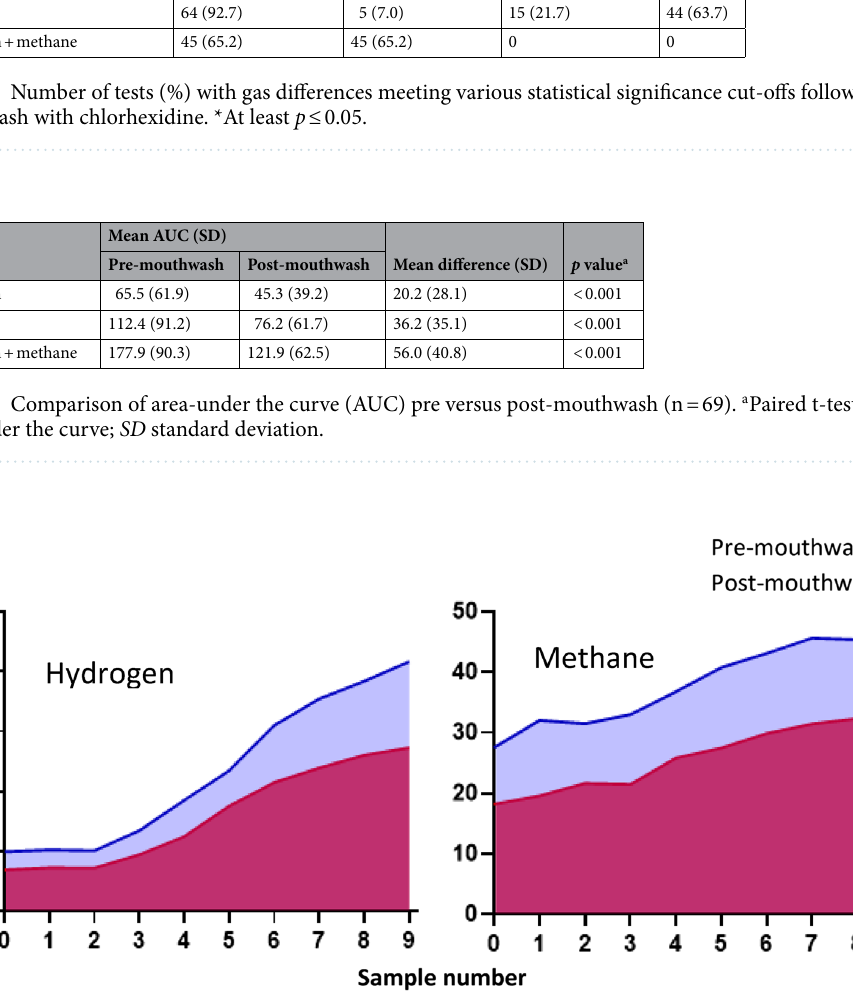
Figure 1. Mean AUC for hydrogen and methane pre versus post mouthwash (pooled data from 69